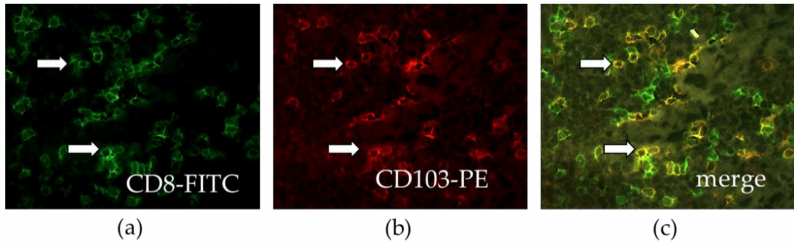
Figure 4. Infiltration of resident memory T cells (CD103 + CD8 + T cells) in human lung cancer. Frozen tissue sections derived from lung adenocarcinoma patients were stained by immunofluorescence with antibodies directed against human ( a ) CD8 (green), and ( b ) CD103 (red). ( c ) The co-localization of CD8 and CD103 markers can be detected by merging the mono-stained pictures. The arrows indicate double positive cells. Staining with isotype controls was included for each experiment (20 ×